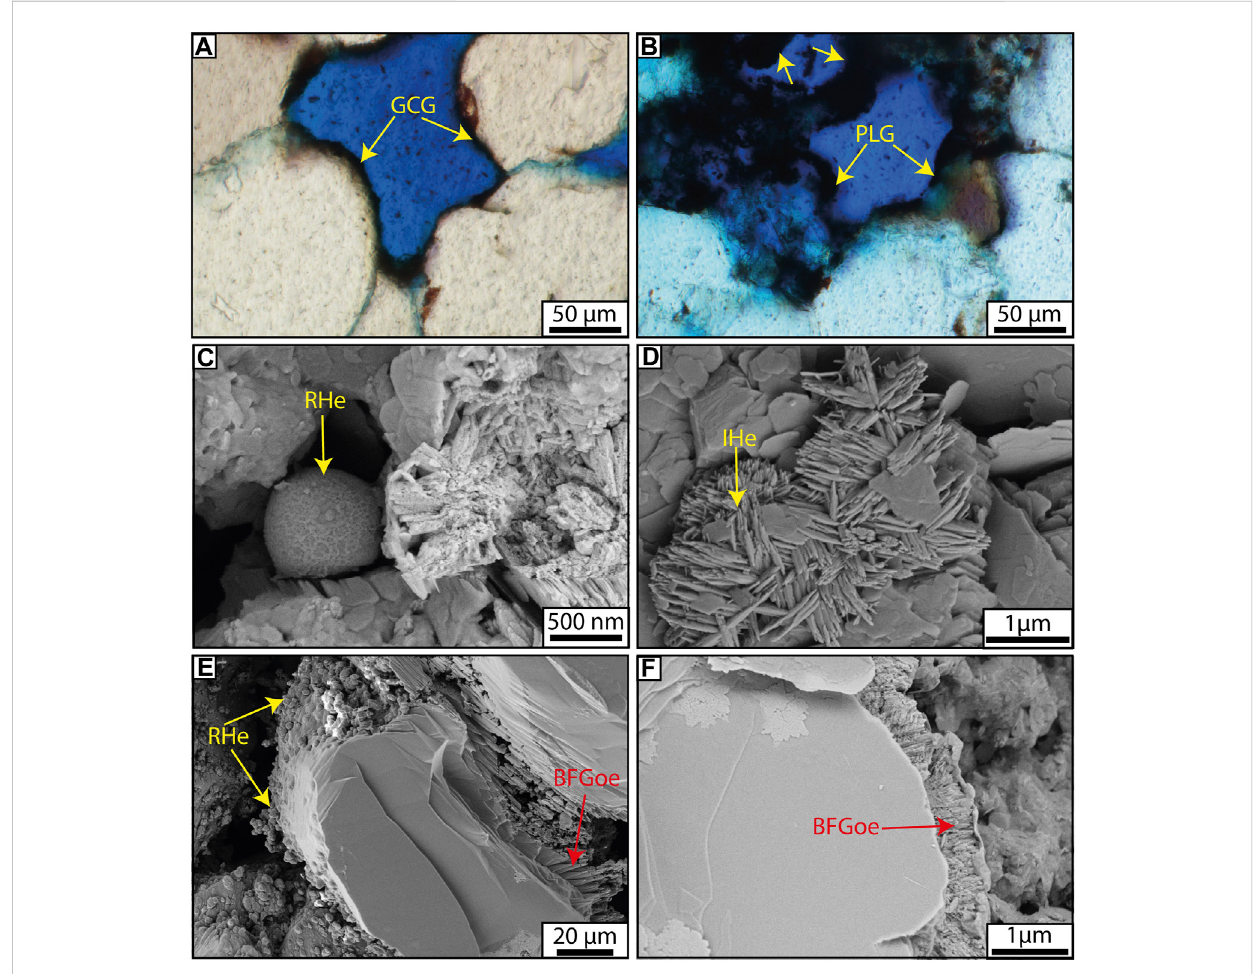
FIGURE 12 Thin-section photomicrographs and SEM images showing the mode of occurrence of Fe-oxide minerals. (A) Grain-coating goethite (GCG). (B) Pore-lininggoethite(PLG). (C) Roundedhematite(RHe). (D) Iridescenthematite(IHe)occurringasneedle-shaped. (E) Roundedhematite(RHe)engul fi ng bird-feather goethite (BFGoe). (F) Bird-feather goethite (BFGoe) occurring as grain-coating cement around detrital